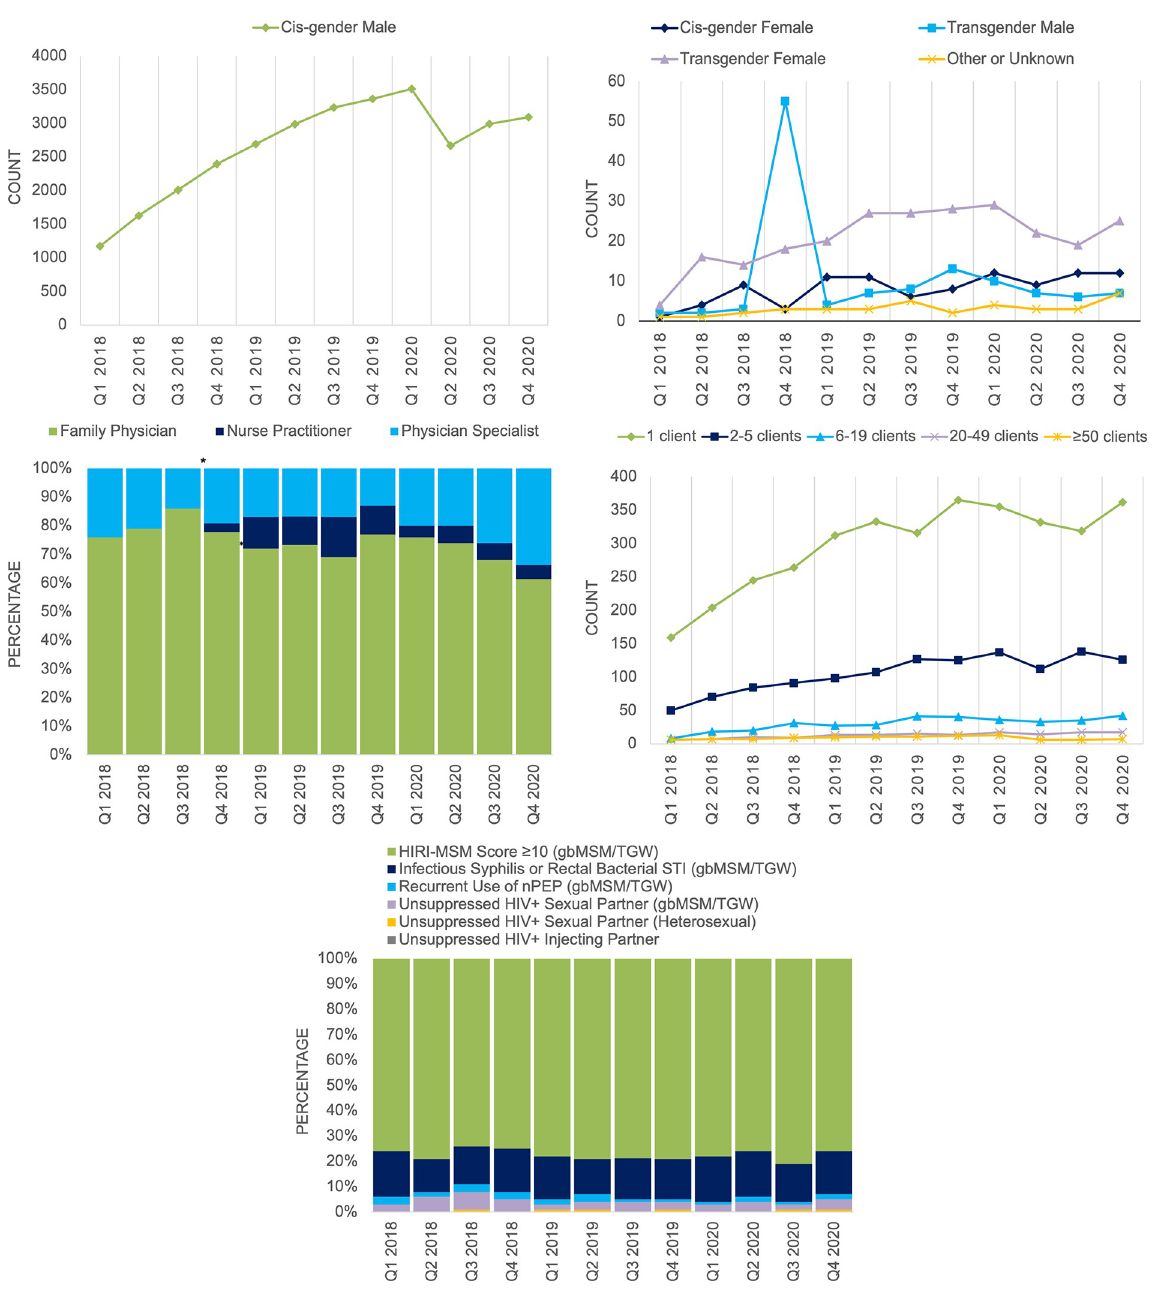
Fig 1. Selected monitoring indicator outputs for BC-CfE in HIV/AIDS pre-exposure prophylaxis program client database. (A) Cisgender male program clients dispensed PrEP by calendar quarters (count). (B) Program clients dispensed PrEP by gender identity except cisgender males (count). (C) New program clients enrolled by provider type (percentage). � Expansion of the nurse practitioner role to prescribe PrEP was started at the beginning of Q4 2018. (D) Providers by the number of program clients (count). (E) New program clients by non-mutually exclusive qualifying HIV risk factors reported at the enrolment